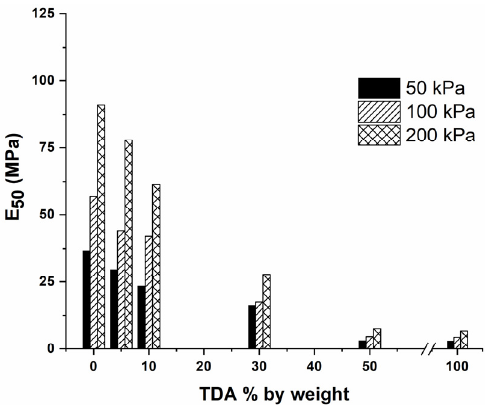
Figure 12. E 50 for TDA-sand samples with 0%, 10%, 30%, 50%, and 100% TDA by weight at confining pressures of 50 kPa, 100 kPa, and 200 kPa.